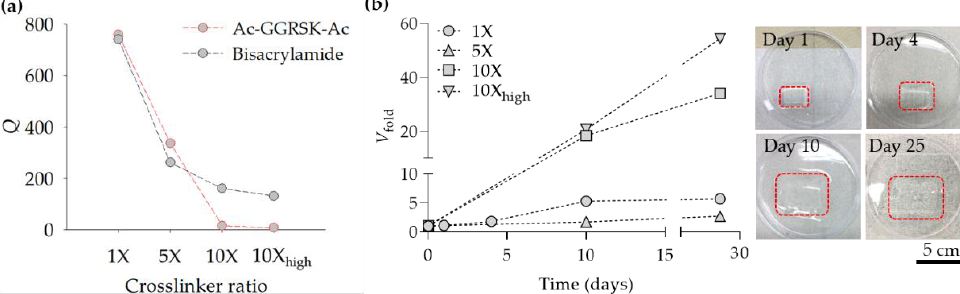
Figure 5. Q and V fold measure for the SAP created with Ac–GGRSK–Ac. ( a ) Q measured for the SAP created with the degradable and non-degradable crosslinkers at a varying crosslinker molar ratio and UV irradiation dose. ( b ) V fold measured over the incubation time for the SAP swollen in PBS containing 1 µ M uPA. In the images, the boundary of SAP is indicated by a dashed red line. The scale bar is 5 cm.